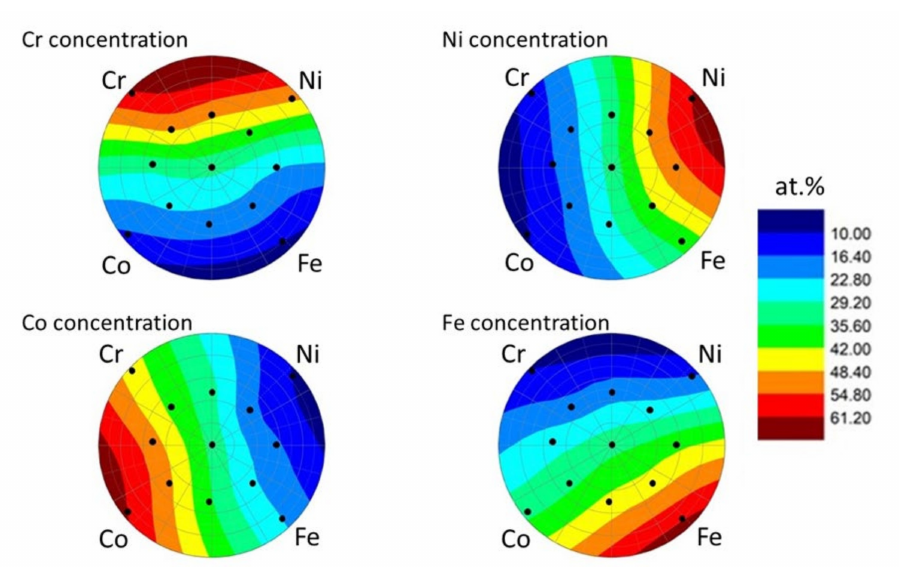
Figure 3. Concentration maps of the four constituent elements as obtained by SEM-EDS. The 13 studied locations are indicated by black